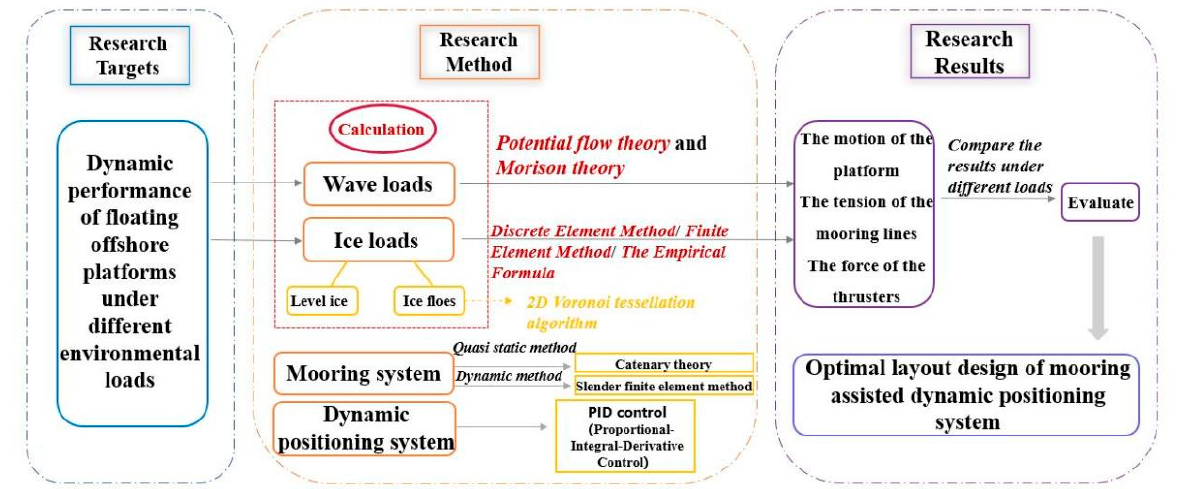
Figure 1. Flow chart of calculation and analysis.